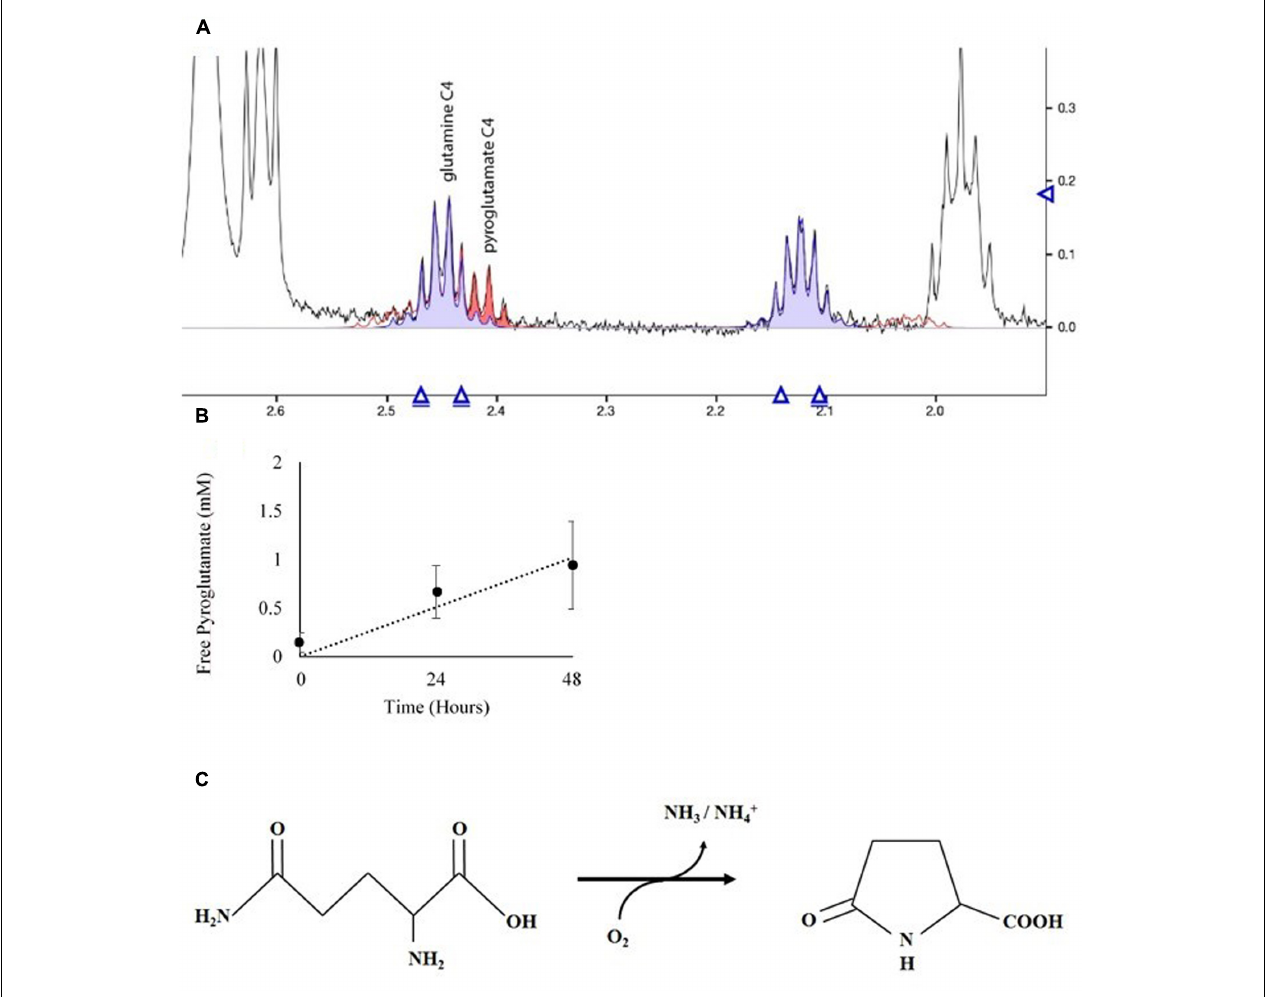
FIGURE 7 | Spectral analysis of spent growth medium containing glutamine. (A) Portion of the NMR spectrum delineating the C4 position of glutamine and its cyclic breakdown compound, pyroglutamate. (B) Time course of pyroglutamate formation in spent media. Means ± Standard Deviation of three independent replicates are shown. (C) Oxidation reaction diagram of glutamine in aqueous solution under oxidizing